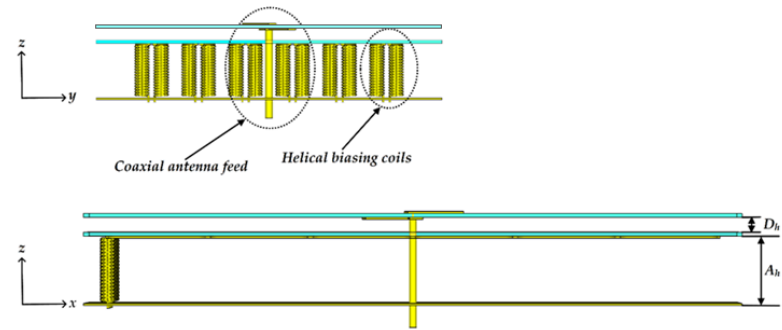
Figure 2. Top view of the antenna. Figure 3. Side views of the Figure 3. Side views of the antenna.